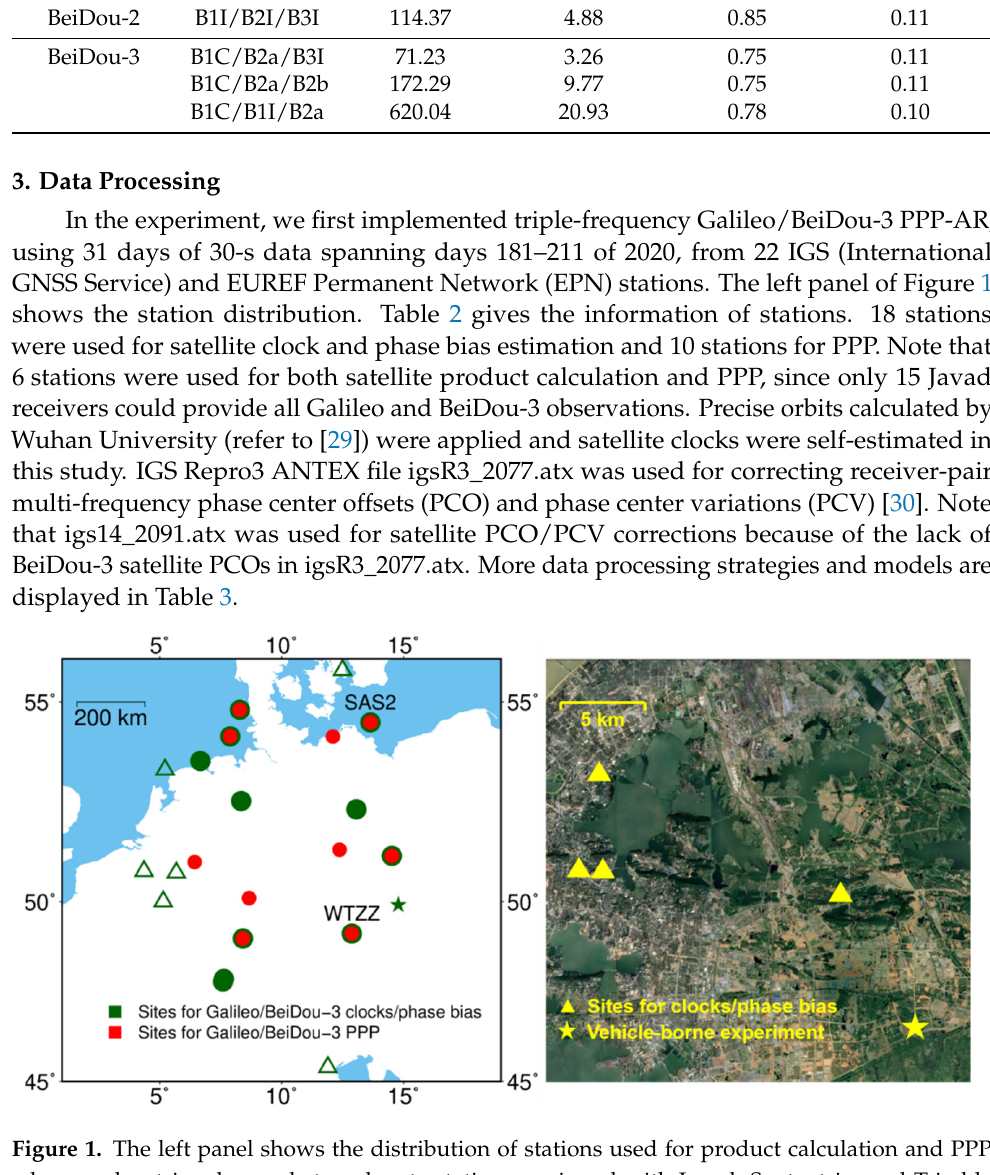
Figure 1. The left panel shows the distribution of stations used for product calculation and PPP where cycles, triangles, and stars denote stations equipped with Javad, Septentrio, and Trimble receivers, respectively. The right panel shows the distribution of the regional network established for vehicle-borne experiment. Table 3. Models and parameter estimation strategies in the data processing.